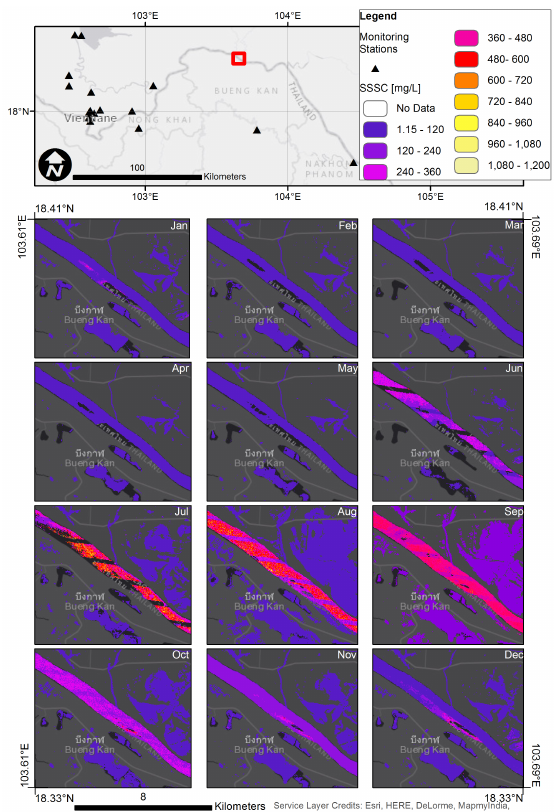
Figure 8. Estimated monthly average SSSC from 1985–2011 near Bueng Kan city located 185 km downstream of the nearest MRC station. Top map displays northeast Thailand bordering Laos with surrounding MRC water quality monitoring stations and an indication of the monthly SSSC maps. The SSSC scale in the legend refers to the monthly maps